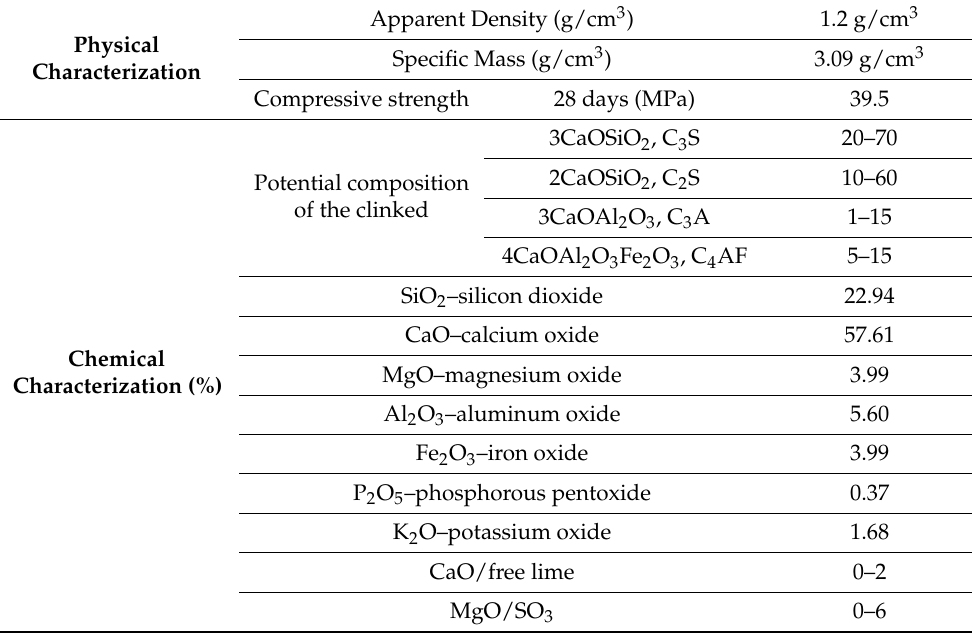
Table 1. Physical and chemical properties of the cement CP II Z-32.